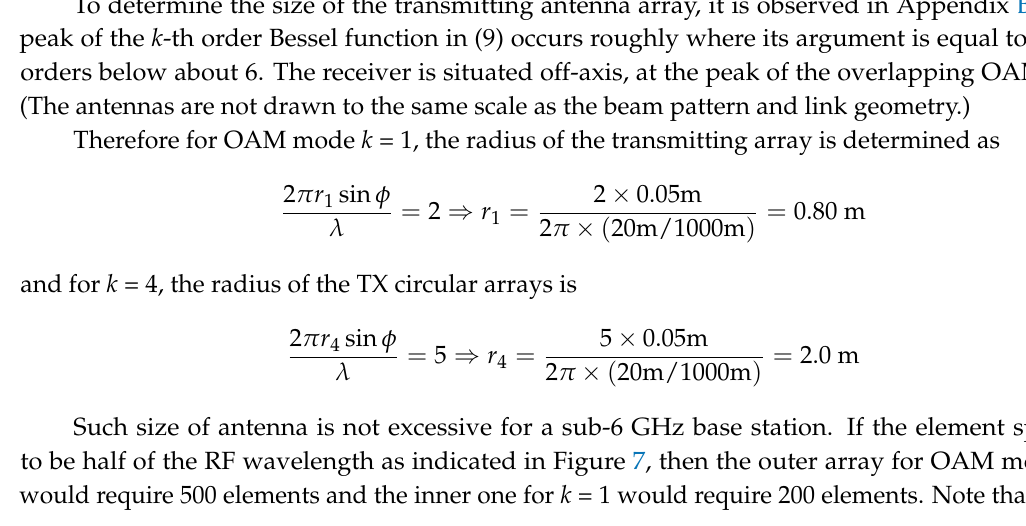
Figure 7. Example of an OAM radio link using pseudo-Doppler modulator in the off-axis